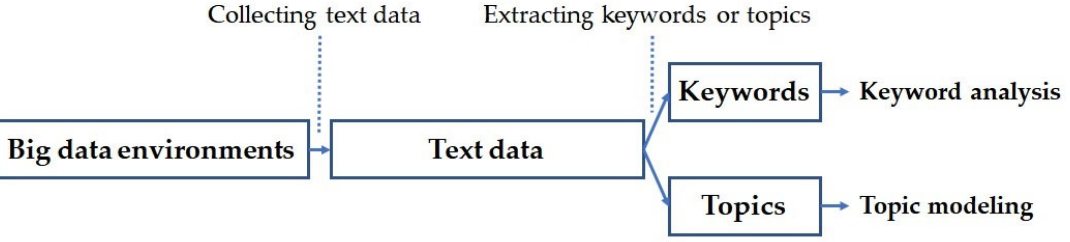
Figure 1. Two approaches to text data